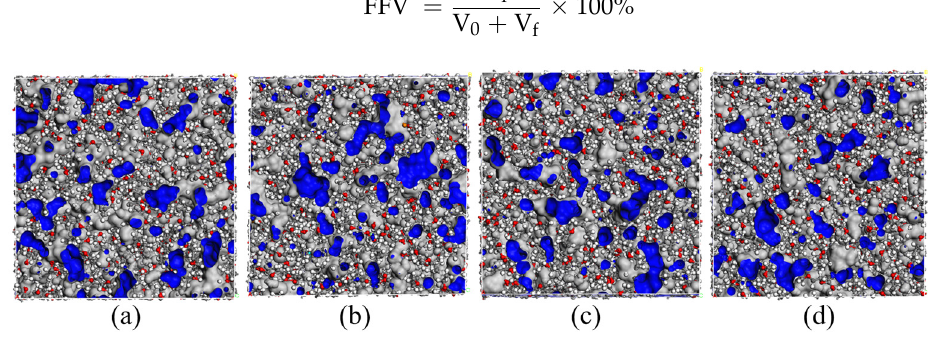
Figure 8. The free volumes of HTPE binders. ( a ) S-1, ( b ) S-2, ( c ) S-3 and ( d ) S-4. Table 3. The results of V 0 , V f , and FFV in the HTPE binder systems.